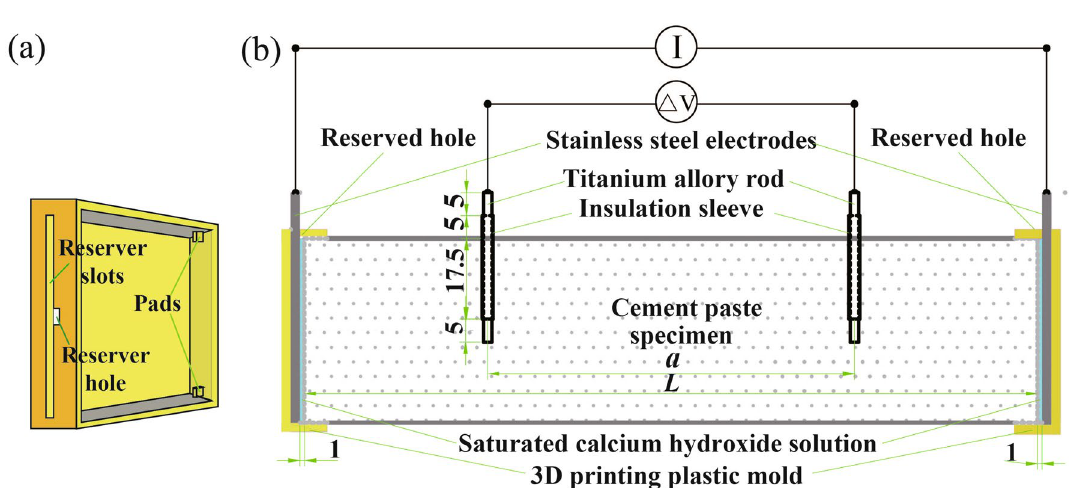
Figure 5. Schematic of the mold with SCH used as the conductive media. ( a ) 3D printing plastic mold; ( b ) Sectional view of sample for the four-point